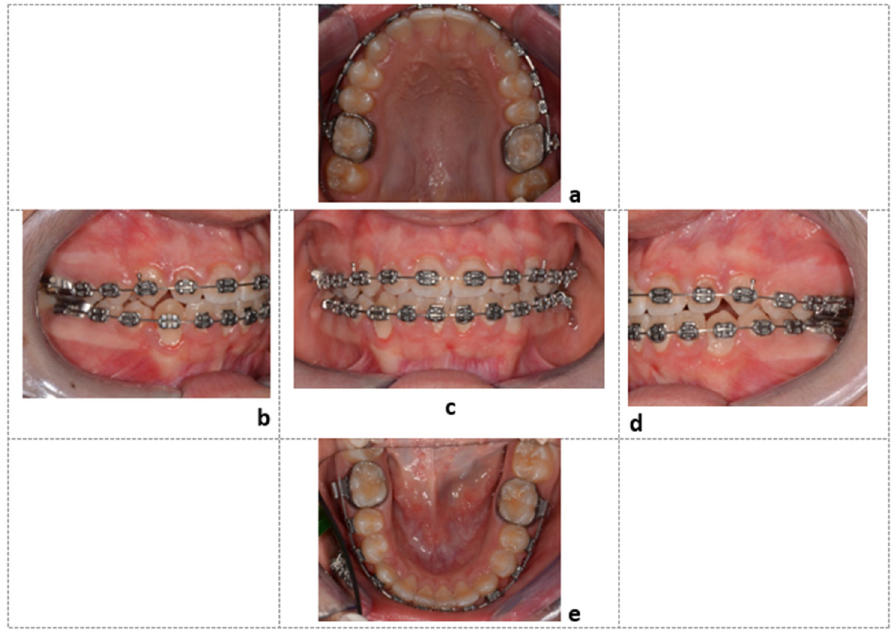
Figure 10. Final intraoral photos of the patient: Element 4.3, recovered in the center of the dental arch, observed from the upper occlusal view ( a ), right lateral view ( b ), frontal view ( c ), left lateral view ( d ), and lower occlusal view ( e ).